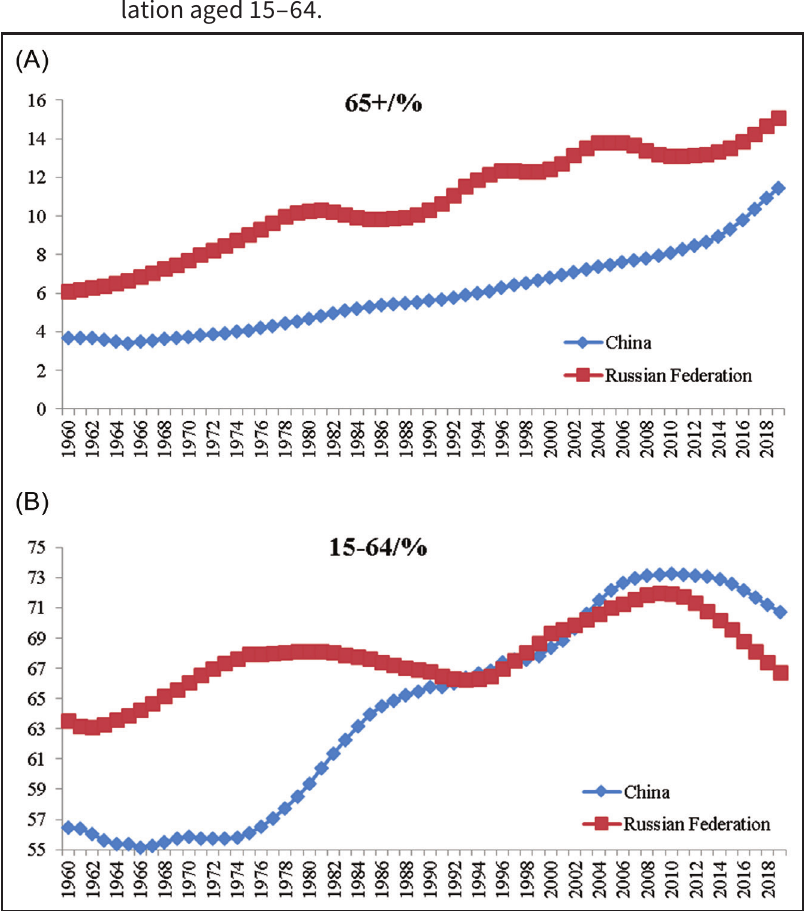
Figure 1 (A) Proportion of population aged 65 + . (B) Proportion of popu- lation aged